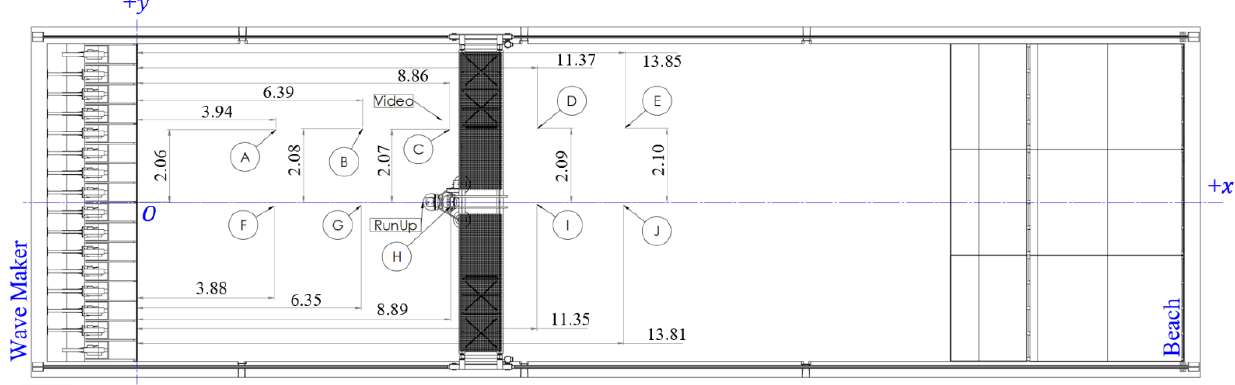
Figure 8. Locations of wave probes during wave calibration in the basin coordinate system (all dimensions in meters at model scale). Drawing adapted with permission from Matthew Fowler, 1/50-scale DeepCwind semi-submersible component wave testing [5]; published by the University of Maine, 2021. Table 3. Locations of wave probes during wave calibration and model experiments in the basin coordinate system (model scale). Wave